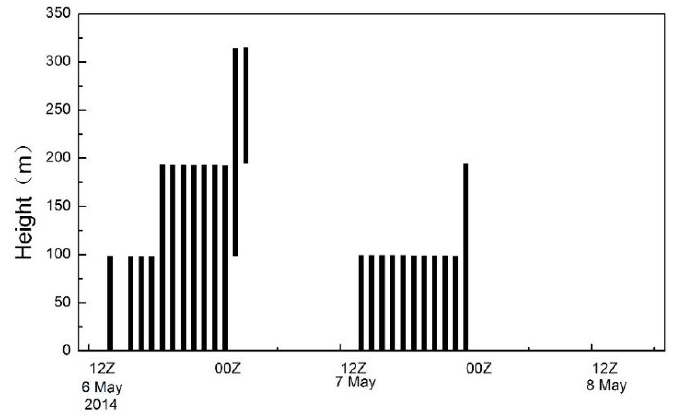
Figure 9. Hourly change in the thickness of the temperature inversion layer over Chengdu during the pollution event (notes: the thickness of the temperature inversion layer was the simulation result obtained based on the mesh closest to the comprehensive substation at the Chengdu University of Information Technology).